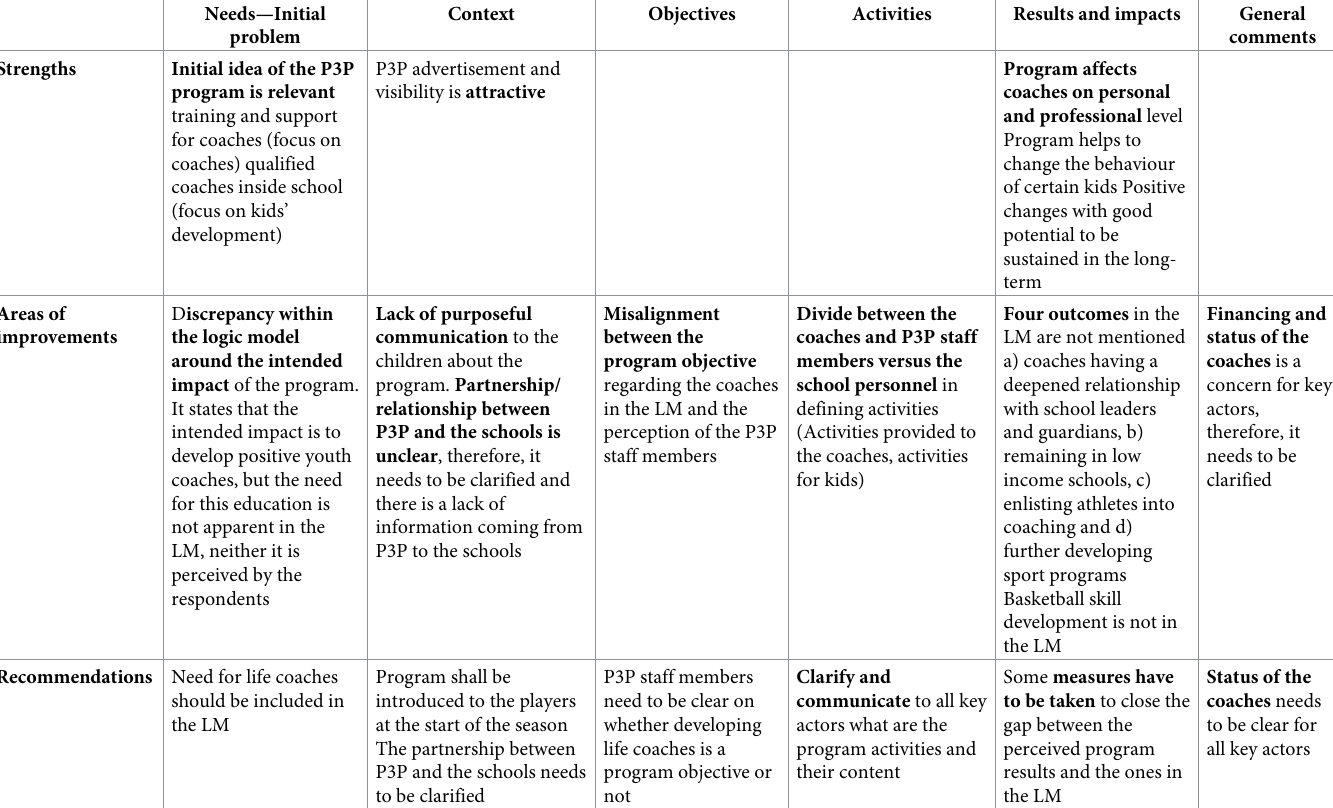
Table 2. Strengths, areas of improvement and recommendations about the Logic model of P3P program. Needs—Initial Context Objectives problem